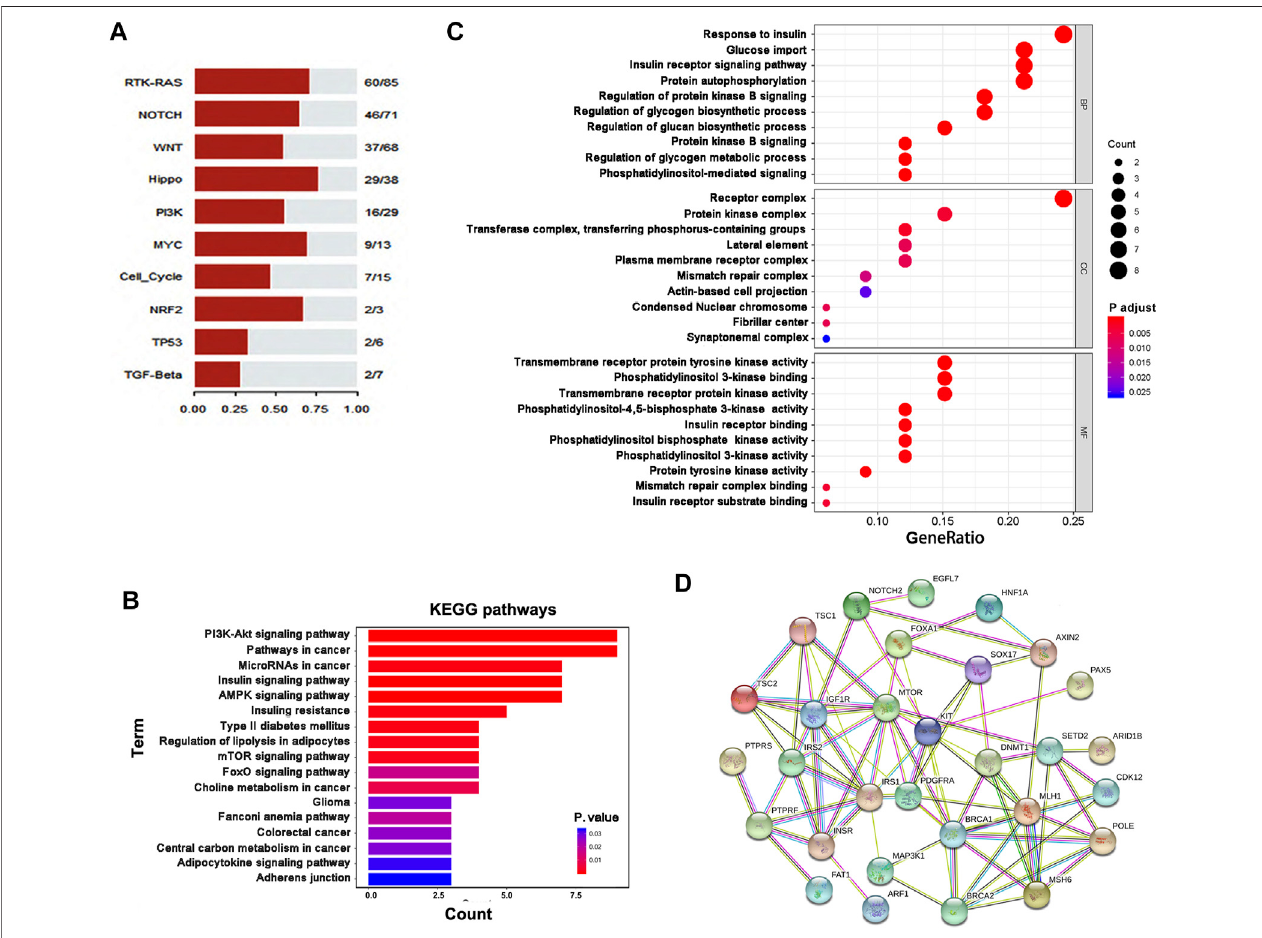
FIGURE4| PathwayenrichmentanalysesofmutantgenesinGIST. (A) Pathwayenrichmentofmutantgenesintencanonicaloncogenicsignalingpathways. (B,C) Enrichment analyses of gene function were performed based on 36 genes using the KEGG (B) or GO (C) pathway database. (D) Protein-protein interaction (PPI) networks were constructed based on 34 genes with mutations in GIST as well as KIT and PDGFRA using STRING software.